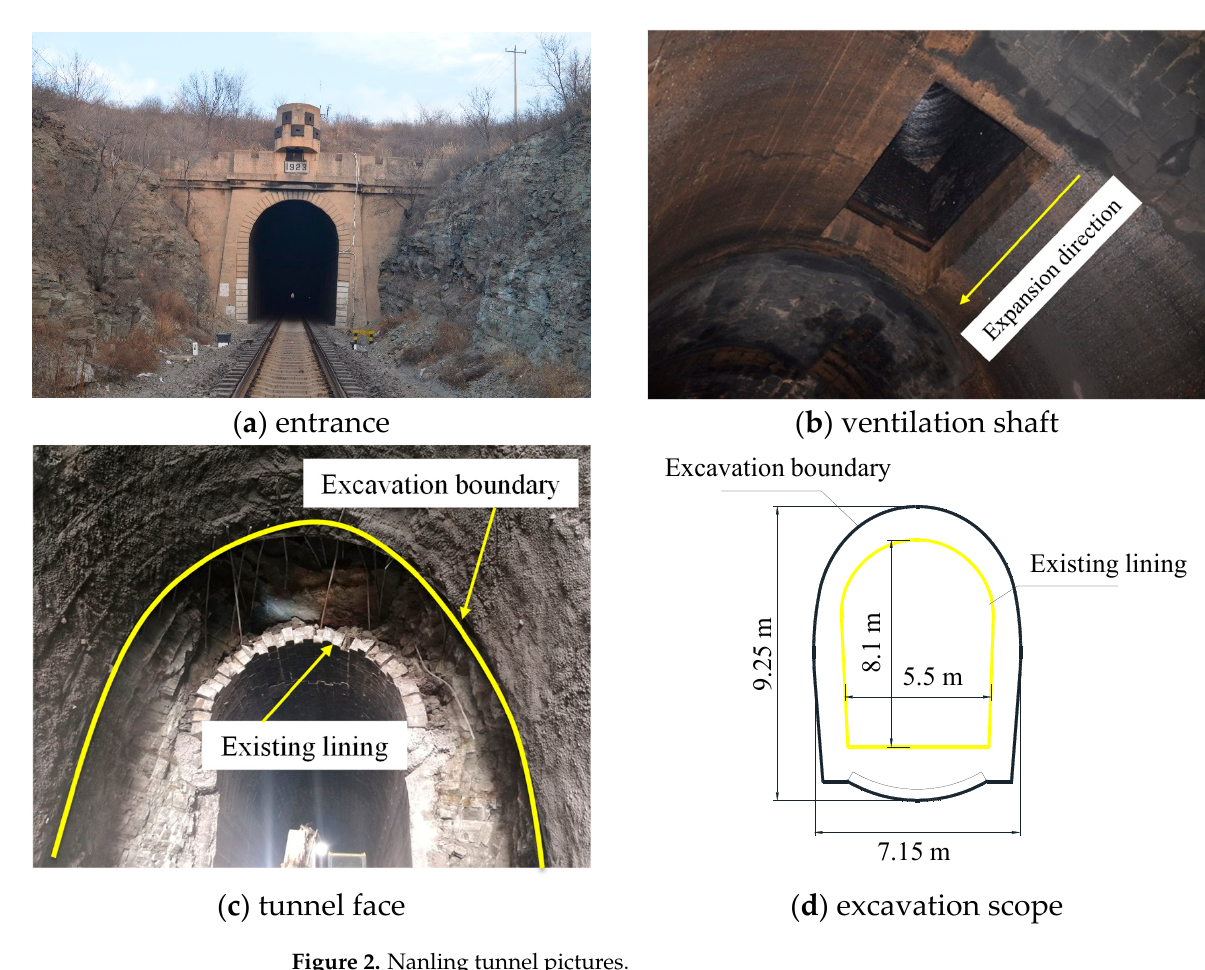
Figure 1. Geological conditions of Nanling tunnel.